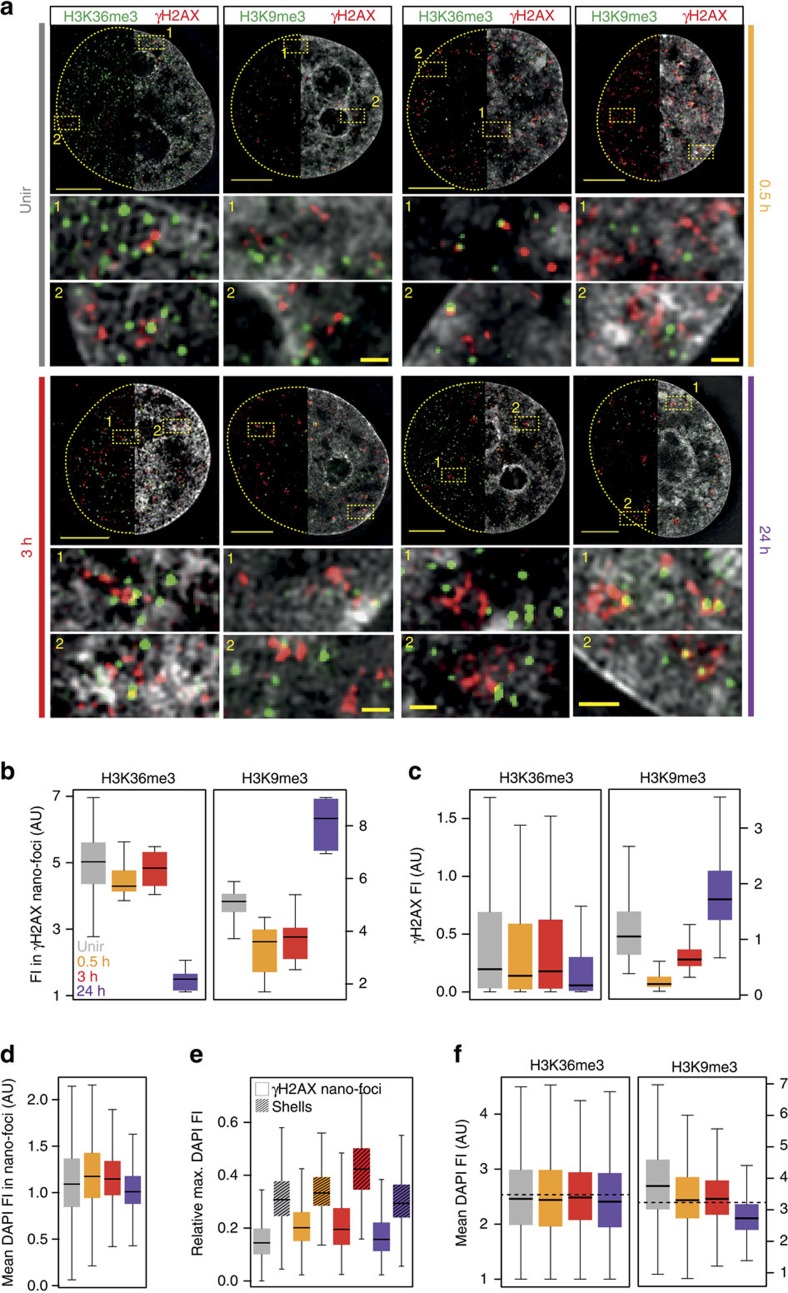
3D-SIM chromatin composition analysis of γH2AX nano-foci before and during DDR.(a) Exemplary 3D-SIM images of γH2AX (red) and H3K9me3/H3K36me3 (green) co-immunostaining before and after IR. Top panels: mid-nuclear sections showing γH2AX and histone marks with (right half) or without (left half) DAPI counterstaining. The dashed lines depict the nuclear contour. Bottom panels: magnification of the yellow dashed boxes with corresponding reference number. Scale bars, 5 μm and 500 nm for main micrographs and magnified regions, respectively. (b) Quantification of the H3K36me3 and H3K9me3 fluorescence intensities measured in γH2AX nano-foci volumes. Kruskal–Wallis χ2=19.875, df=3, P=1.802 × 10−4 and Kruskal–Wallis χ2=24,451, df=3, P=2.011 × 10−5. (c) Quantification of the γH2AX fluorescence intensity in H3K36me3- (Kruskal–Wallis χ2=261,960, df=191,020, P<2.2 × 10−16) and H3K9me3- (Kruskal–Wallis χ2=246,300, df=232,750, P<2.2 × 10−16) decorated chromatin. (d) Mean DAPI intensity in γH2AX nano-foci. Kruskal–Wallis χ2=247,910, df=245,320, P=1.129 × 10−4. (e) Quantification of maximum DAPI intensity in the volume occupied by γH2AX nano-foci (regular boxes) and shells (pattern), relative to the maximum integrated nuclear intensity. Shells represent 3D hollow structures surrounding γH2AX nano-foci (Supplementary Fig. 5E and ‘Methods' section). Wilcoxon rank sum all <2.2 × 10−16. (f) Mean DAPI fluorescence intensity in H3K36me3- or H3K9me3-decorated chromatin. Kruskal–Wallis χ2=303,050, df=292,700, P<2.2 × 10−16 and Kruskal–Wallis χ2=25,500, df=25,002, P=0.01338. Dotted lines: mean DAPI intensity measured over the whole analysed nuclei. All boxes and whiskers are as in Fig. 1. AU: arbitrary units. Results are from two independent experiments.